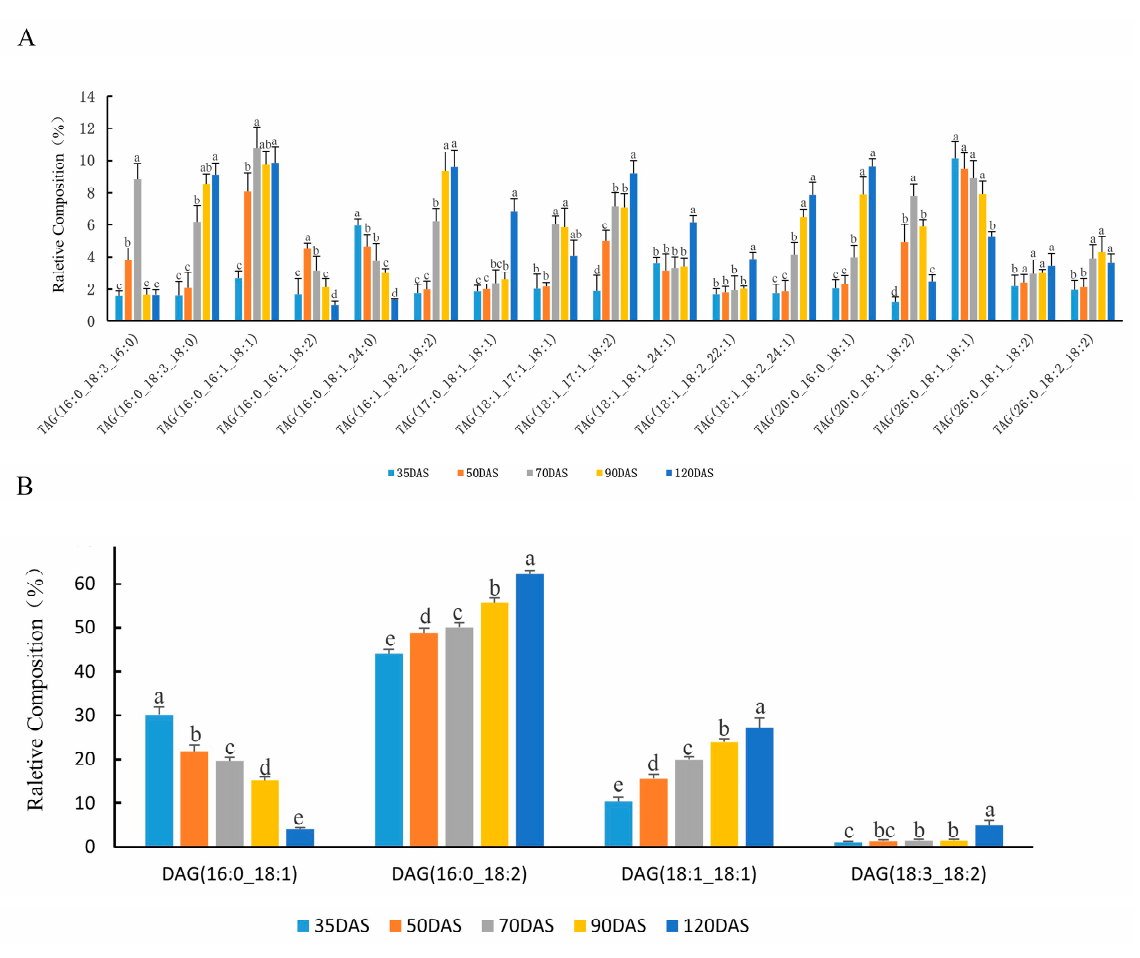
Figure 3. Profiling of different molecular types of glycerolipid classes during tuber development. Triacylglycerol ( A ) and Diacylglycerol ( B ) molecular types were analyzed by LC/MS as described in Materials and methods. Five developmental time points were analyzed, 35, 50, 70, 90, and 120 days after sowing (DAS) for oil accumulation. One-way analysis of variance (ANOVA) was carried out to compare statistical differences (Ducan, p < 0.05), Data are means ± SD ( n = 6).